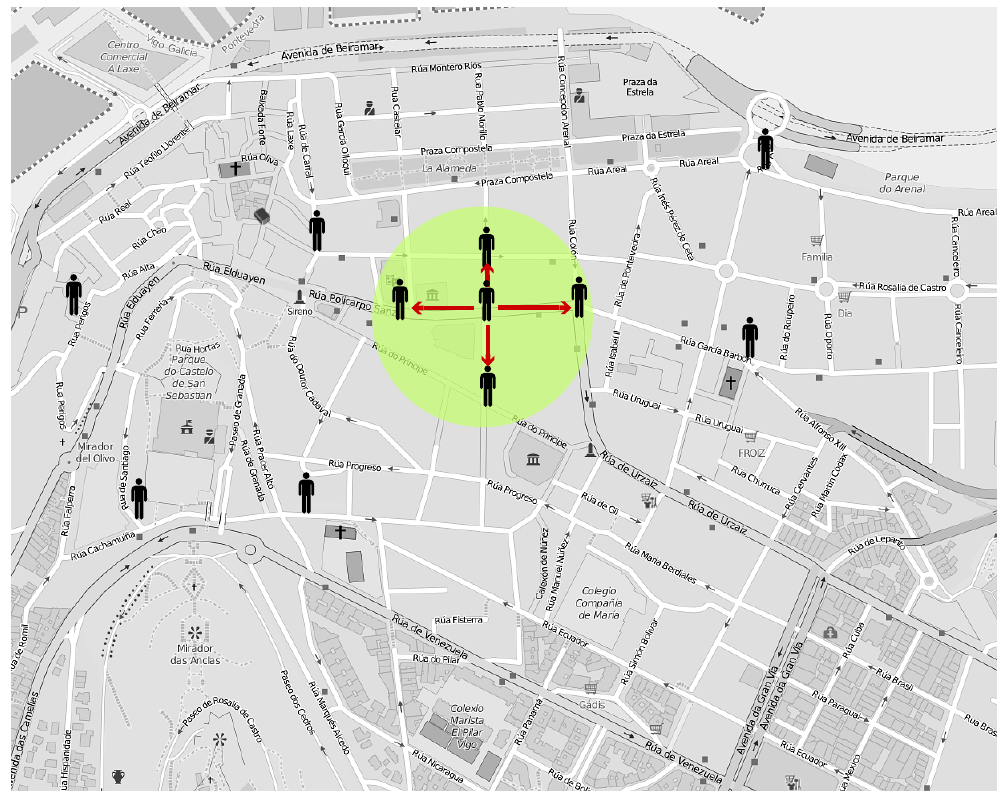
Figure 5. Urban area used in simulation. An example of the proximity area around a producer is represented with a green